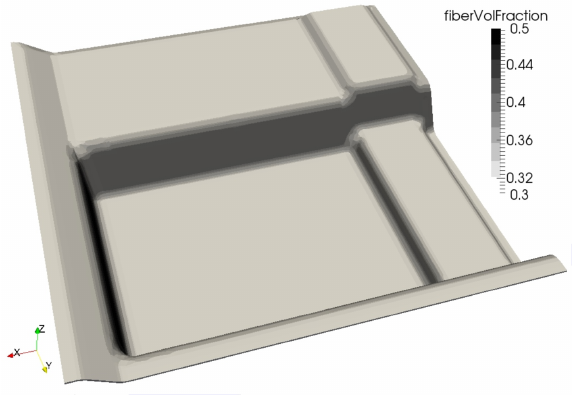
Figure 10. Fiber volume fraction of the complex part at the beginning of the simulation.